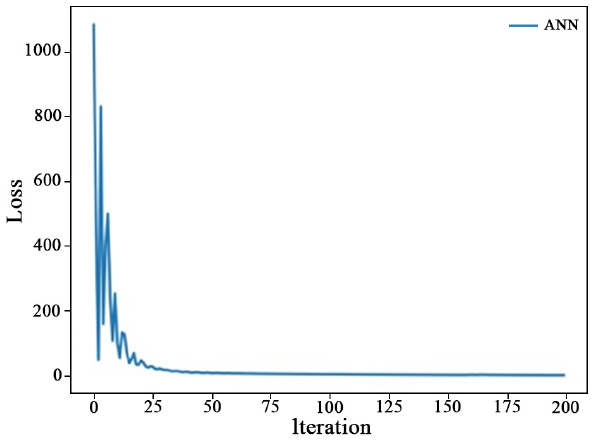
Fig. 11. When the network iterates 2000